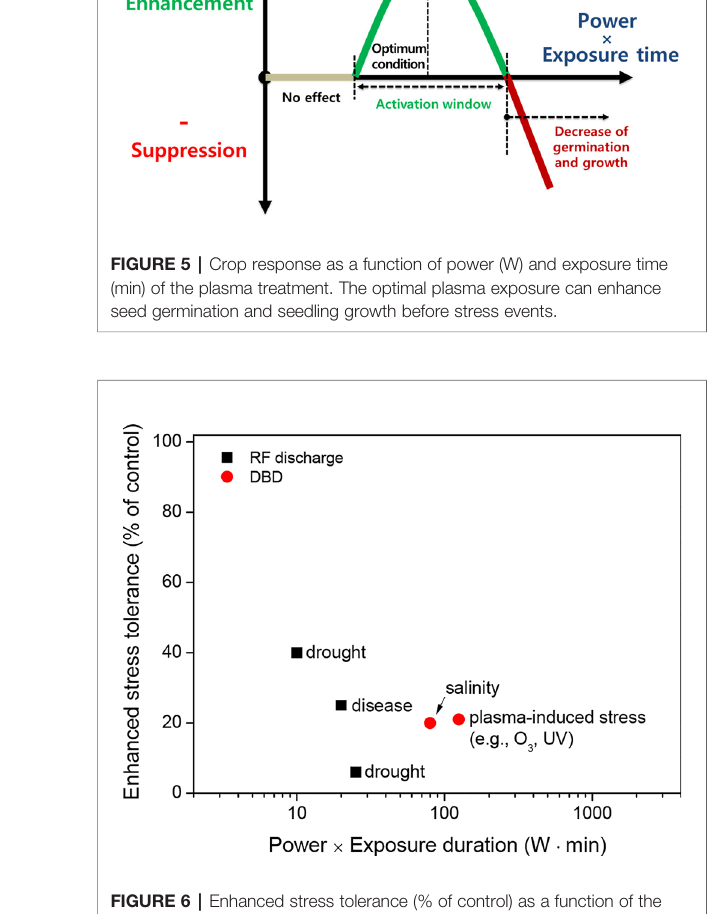
FIGURE 6 | Enhanced stress tolerance (% of control) as a function of the power (W) and exposure time (min) of the plasma treatments on seeds (or seedlings), which were described in the literature presented in Table 4